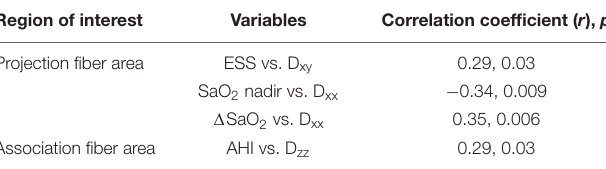
TABLE 4 | Correlation between periventricular projection and association diffusivity parameters and sleep severity and sleep symptoms in OSA subjects. Region of